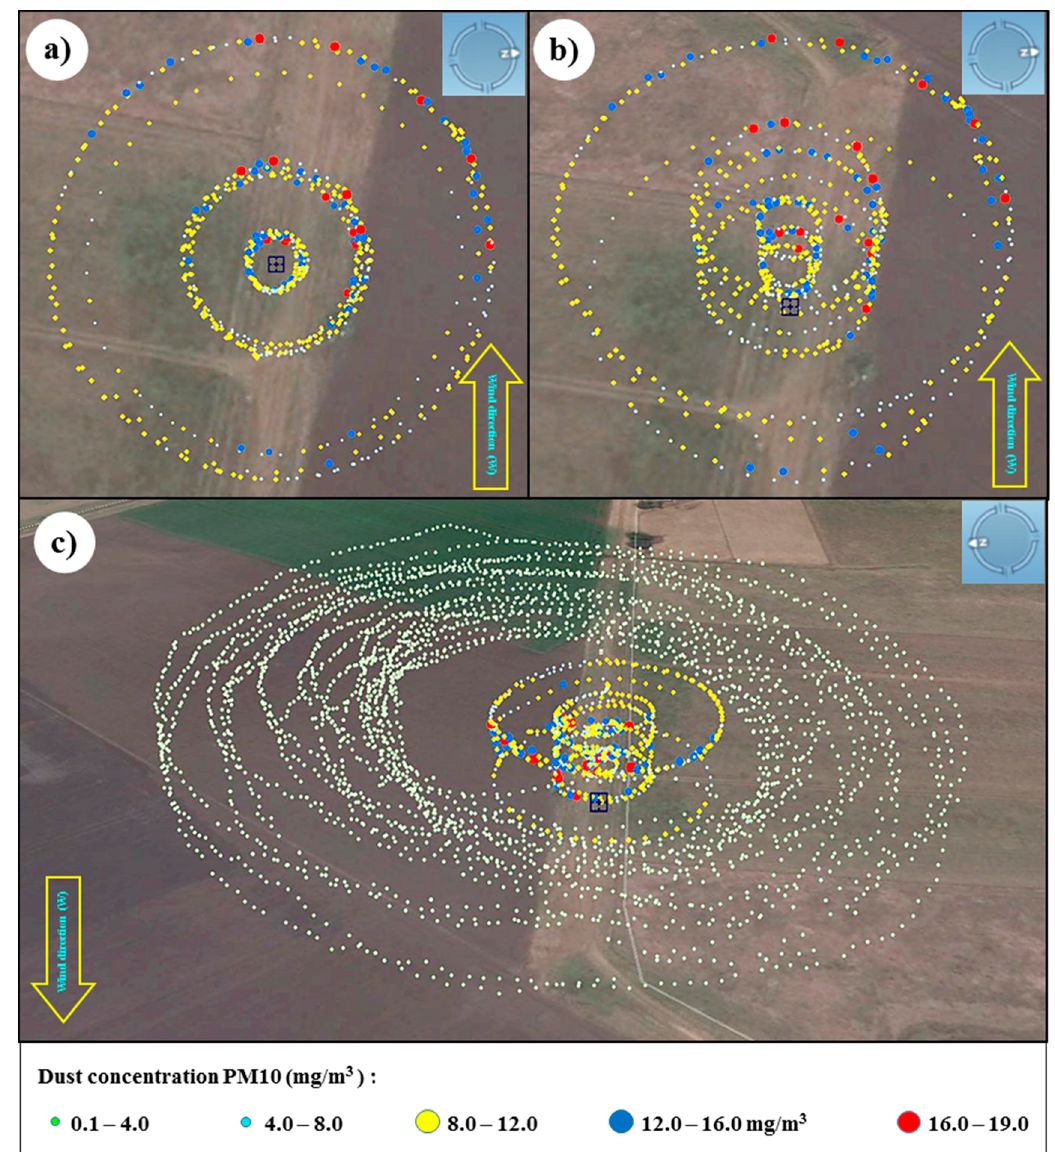
Figure 16. Flight path and PM10 concentrations monitored with the UAV quadcopter ( a ) top view and ( b ) side view; and ( c ) fixed-wing and quadcopter (overlapped